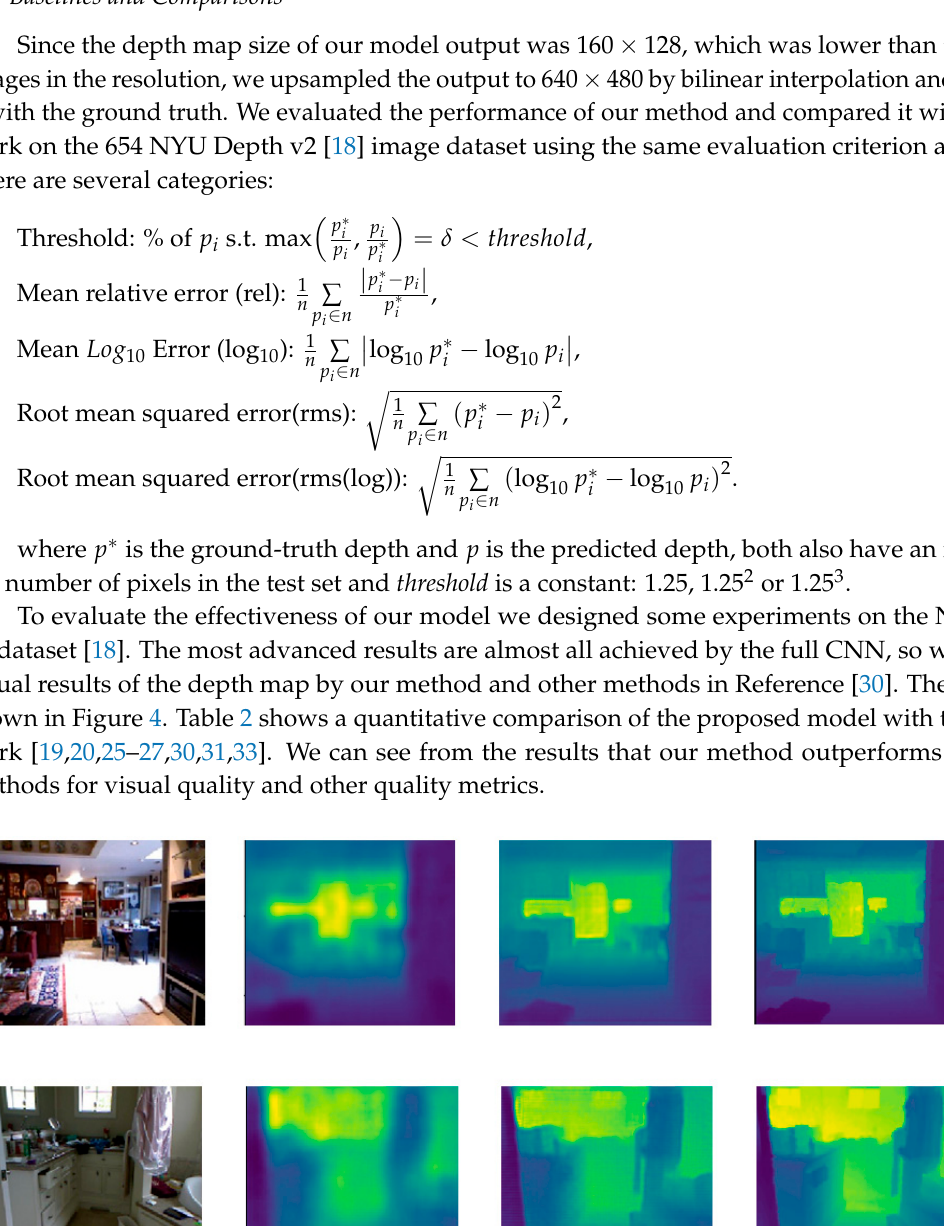
Figure 4. Example depth results. ( a ) RGB image; ( b ) result in Reference [30]; ( c ) our result; ( d ) ground truth. Note that the color range of each image represents the distance of the camera to the object. Table 2. Quantitative comparison with state-of-the-art-based methods on the NYU Depth v2 dataset [18]. For the δ accuracies, higher is better; for the others, lower is better. Method